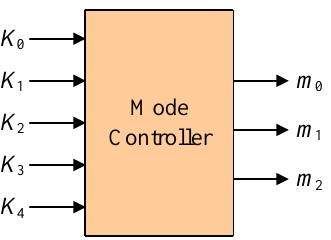
Figure 5. The module of the mode